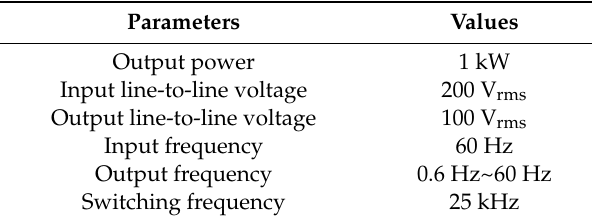
Figure 8. Experimental setup. Table 4. System parameters.